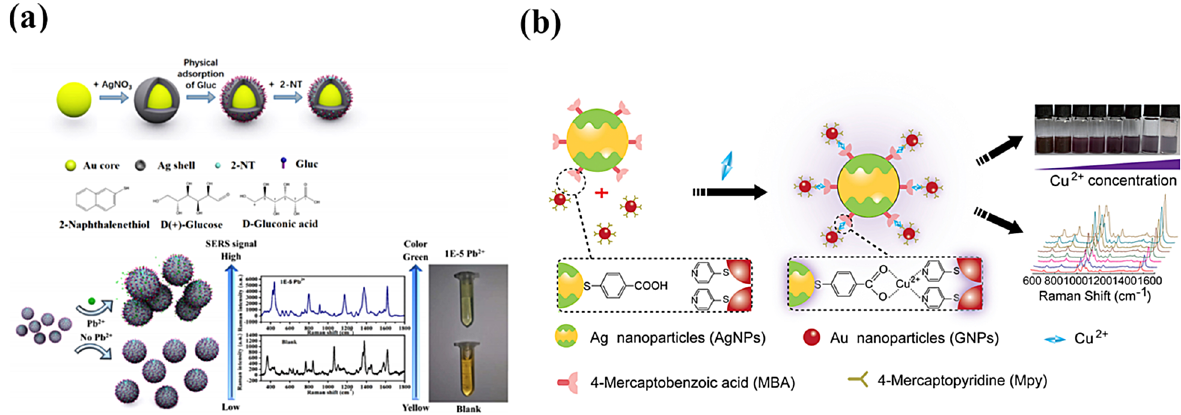
Figure 10: Colorimetric and SERS dual-mode strategies for the detection of heavy metal ions. (a)AcolorimetricandSERSdual-modestrategyforthedeterminationofPb 2 + ionsbasedonAu@AgNPsfunctionalizedwithGlucand2-NT[130]. (b) Colorimetry/SERS dual-channel sensor for trace analysis of Cu 2 + ions based on AgNPs – Cu 2 + – GNPs core – satellite structures